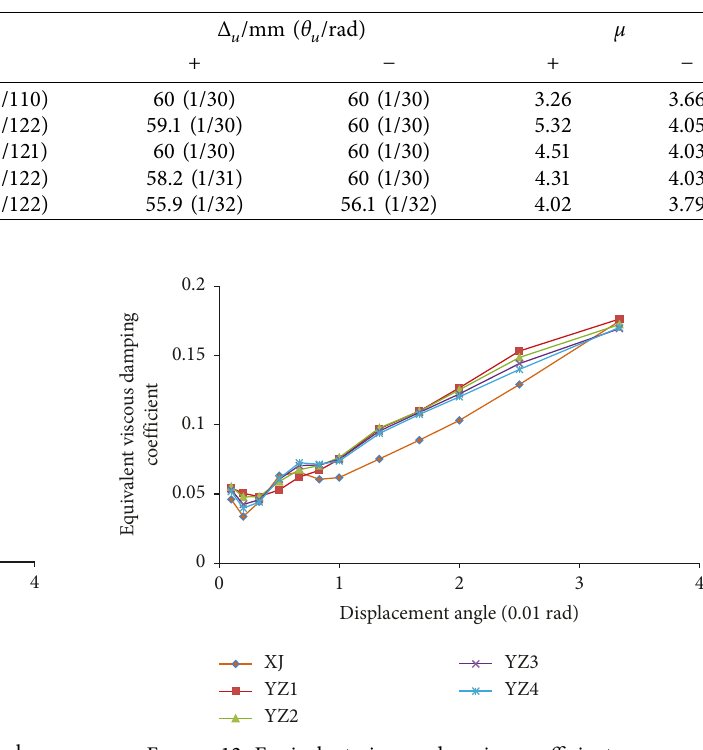
Table 4: Displacement ductility coefficient.